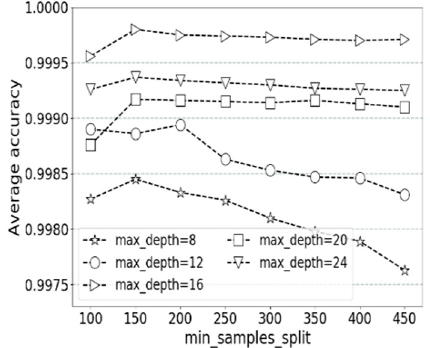
Figure 7. max_depth and min_samples_split.